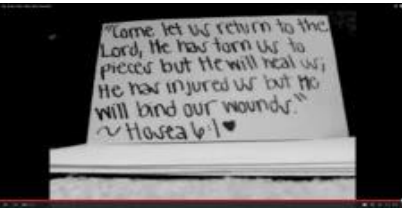
Figure 3. Farewell. Source: https://www.youtube.com/